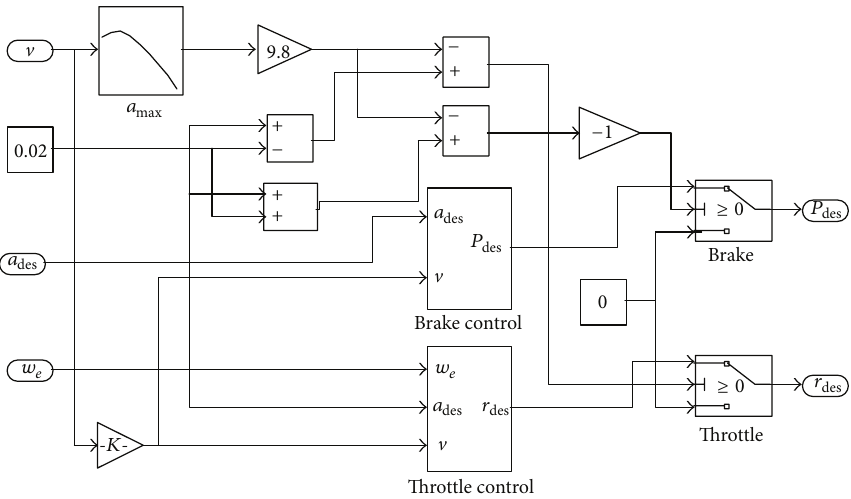
Figure 3: Switching logic schematic of the throttle control and brake